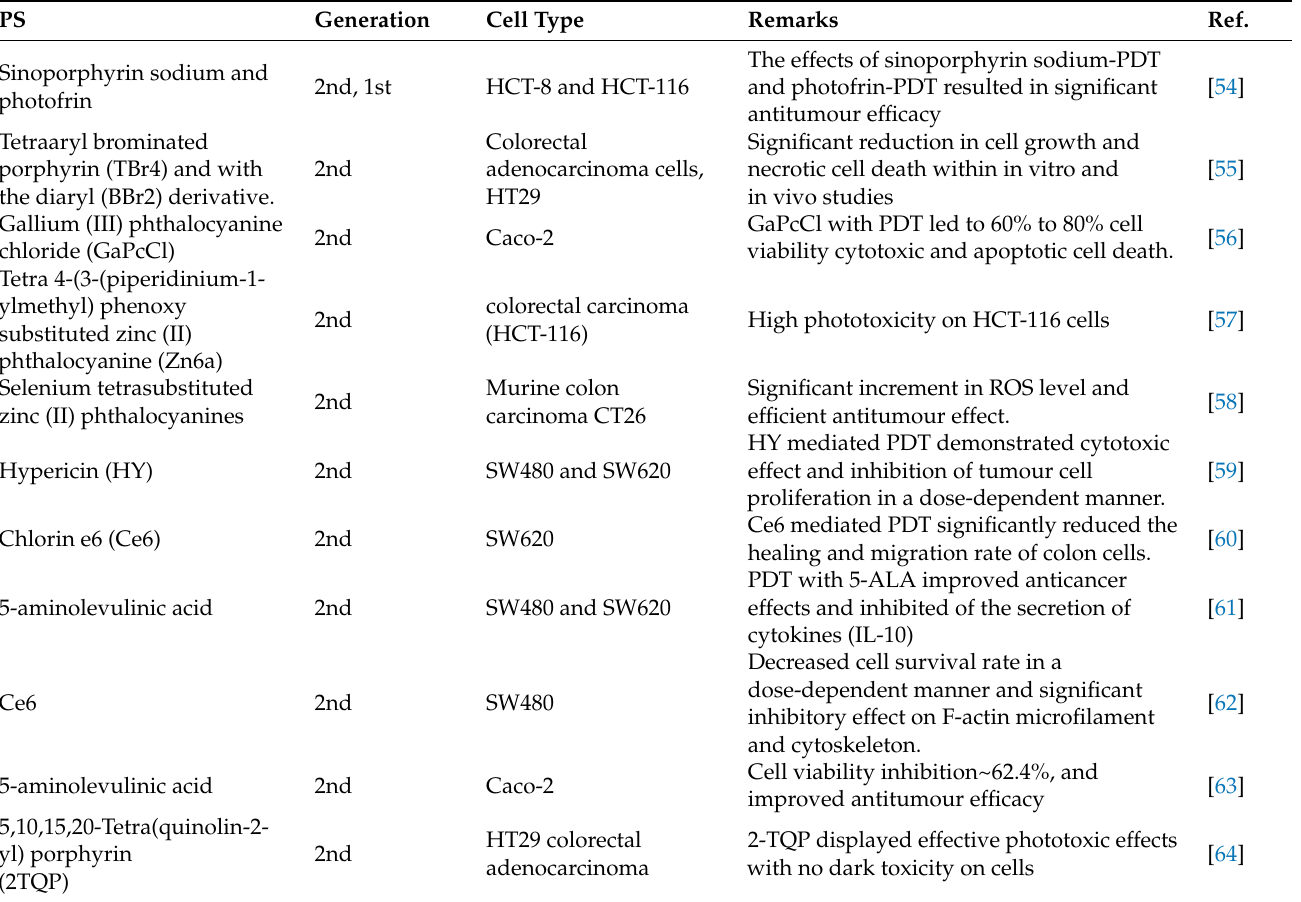
Table 1. First- and second-generation photosensitizers evaluated in pre-clinical studies for CRC PDT. PS